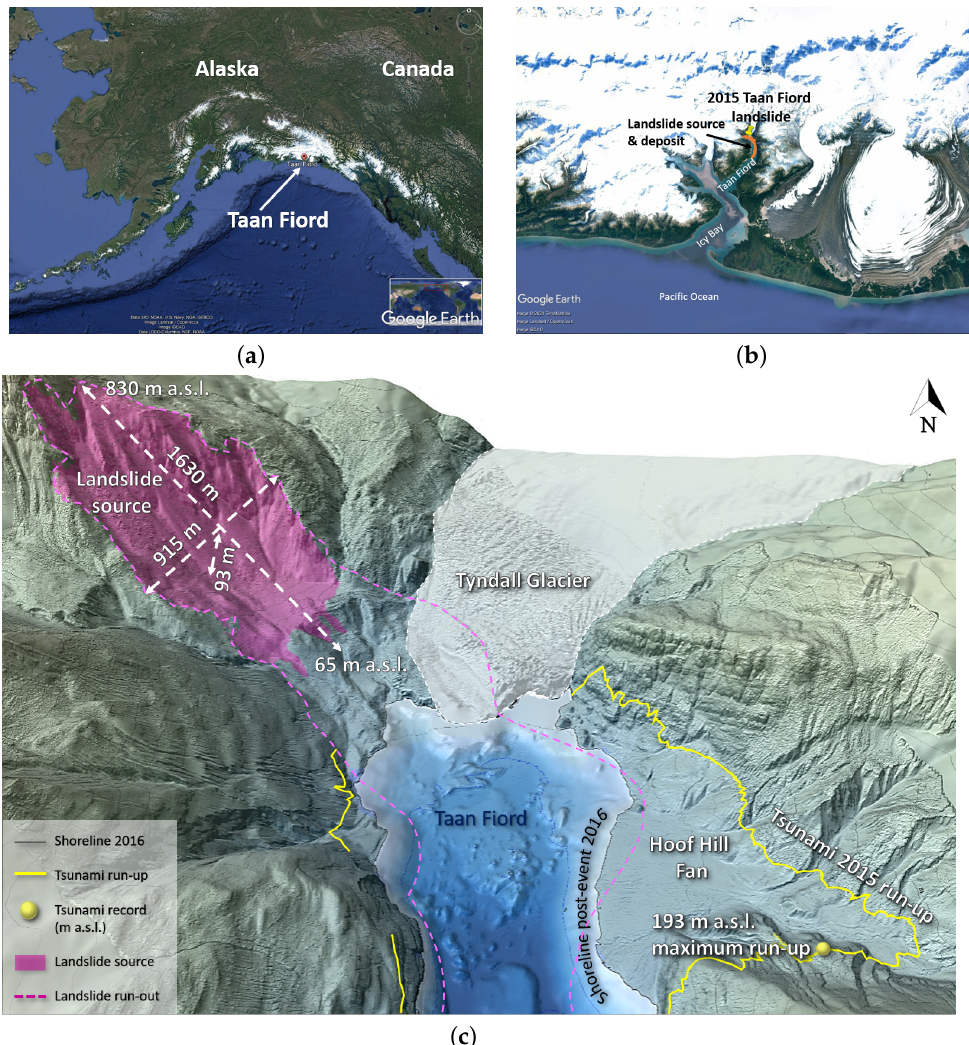
Figure 1. The landslide source area. ( a ) The location of Taan Fiord, southern Alaska (using Google Earth Pro) ( b ) Location of the landslide source area in relation to Taan Fiord (using Google Earth Pro). ( c ) The landslide source and corresponding impact area (modified from Franco et al.